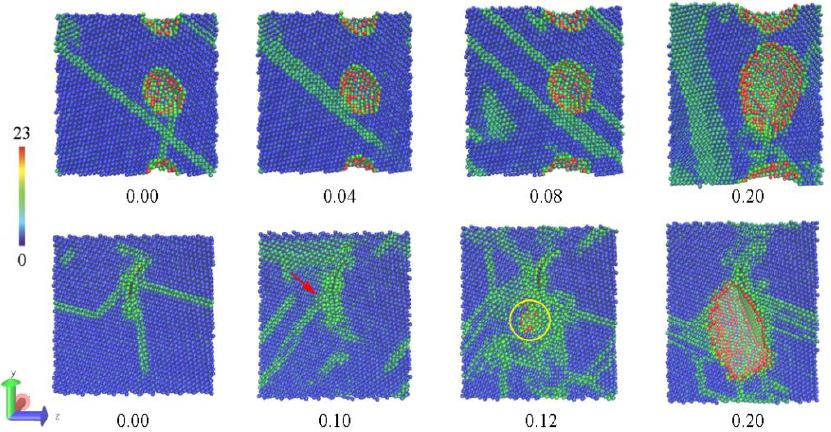
Figure 4. The changes in the inner structure under different strains in the tensile process. The pure Al structure is shown in the upper row, while the structure of the composite with SLG is shown in the lower row.